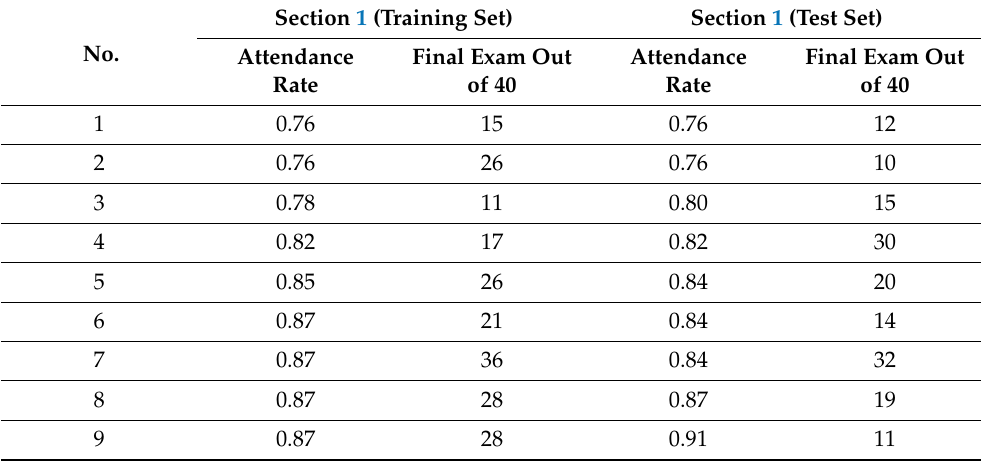
Table 2. The experiment data